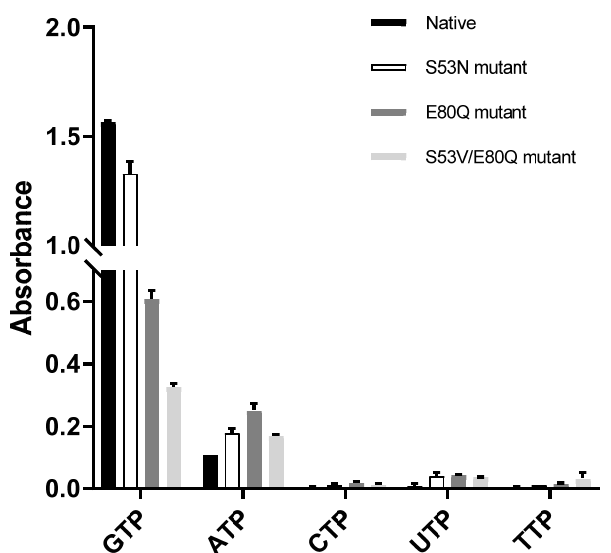
Figure 3. The comparison of absorbance of native Yp HddC, S53N, E80Q, and S53V / E80Q mutants. The malachite assay was performed with 0.25 mM NTP and 1 mM α M1P. The observed absorbance could be considered as the reactivity of HddC. Compared to native Yp HddC, the guanine preference of mutants fell drastically. However, pyrimidines were not recruited unlike other HddC homologs. The variation in the pyrimidine specificity of mutants seemed to be insignificant. In contrast, the usage of ATP went up a bit.